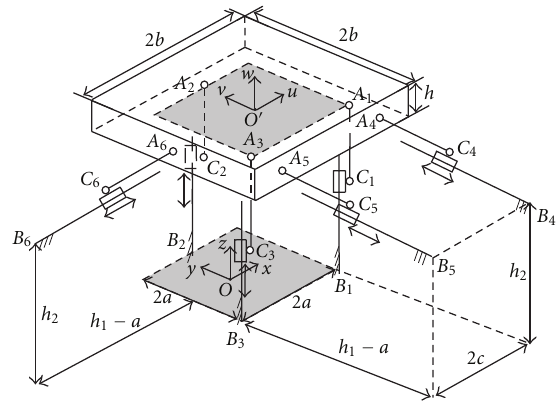
Figure 1: Schematic diagram of the 6-dof parallel structure seismic